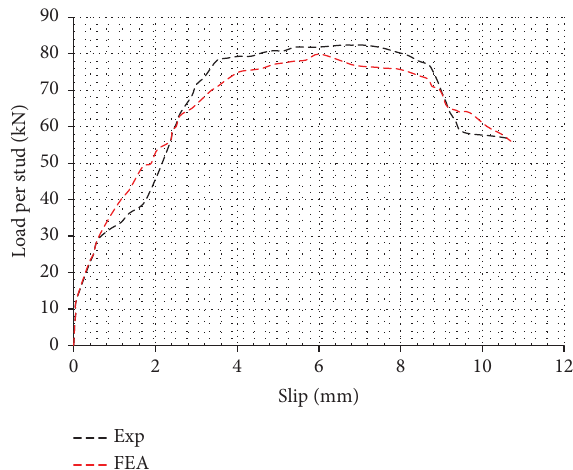
Figure 8: Comparison between FE model and experimental result.